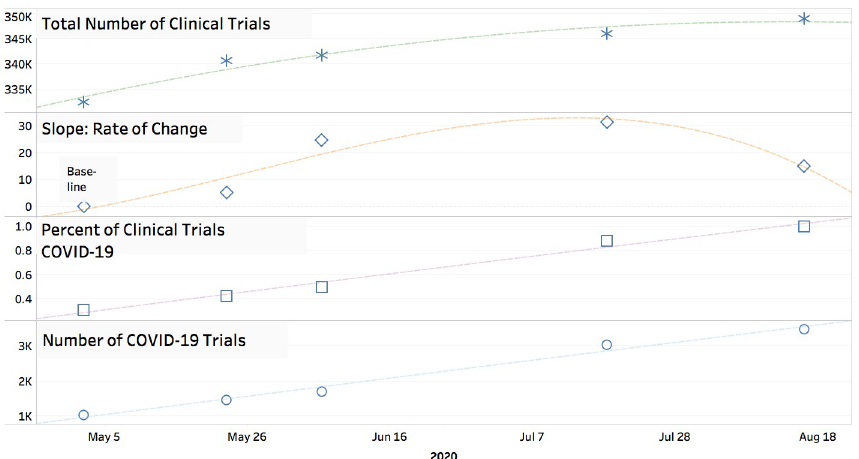
Fig 1. COVID-19 clinical trial trends: Longitudinal trends from COVID-19 related clinical trials. The data is plotted across five time points: May, 3rd 2020, May, 23rd, 2020, June 6th, 2020, July 18th, 2020, and August 16, 2020. (a) The total number of clinical trials at each time points; (b) Percent of new clinical trials (trials published between time segments) that are COVID-19 related; (c) Percent of all clinical trials that are COVID-19 related; (d) The total number of COVID-19 related clinical